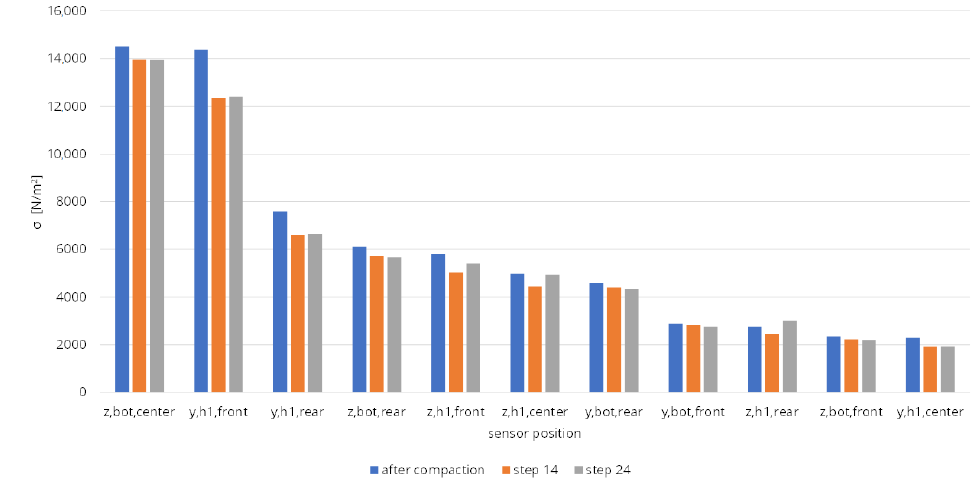
Figure 12. Distribution of residual pressure in the sand for the zero load steps of the test program.